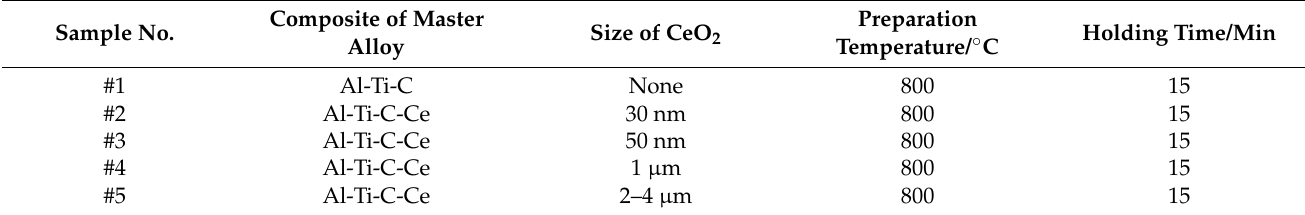
Table 1. The experimental parameters and numbers of master alloys.